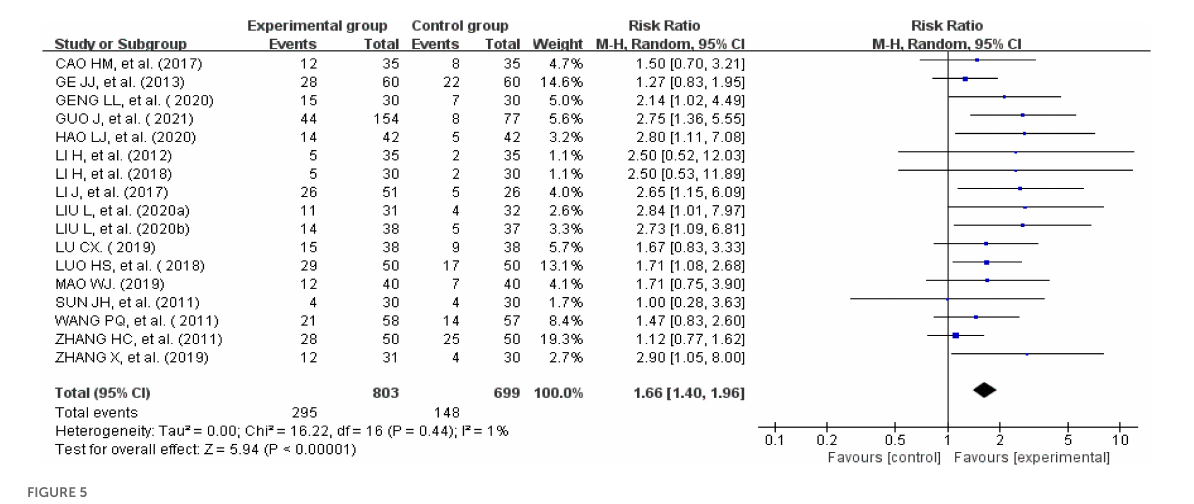
FIGURE5 Forest plot of the clinical cure